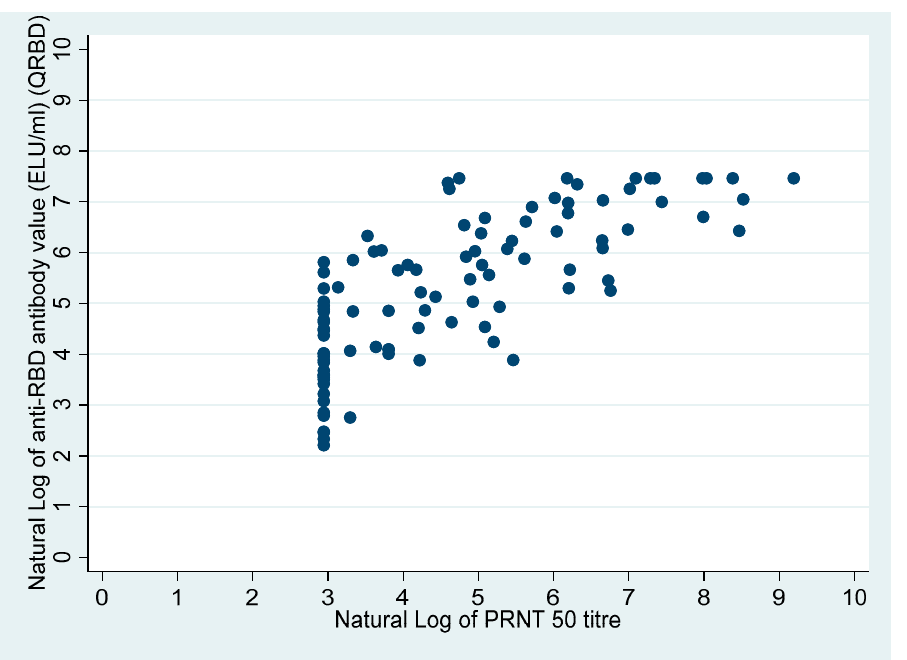
Figure 4. Scatter plot of anti-RBD antibodies (ELU/mL) among participants with neutralizing antibody titres (The scales are natural logarithms).